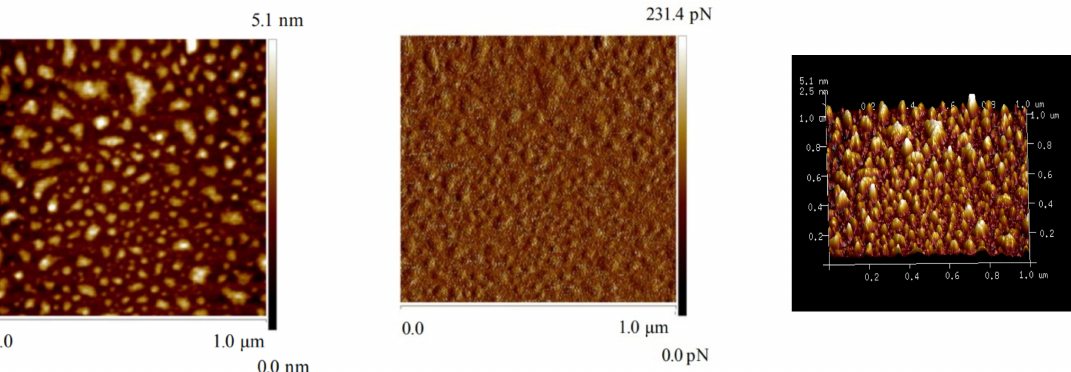
Figure 13. Height, Peak Force Error, and 3D image of talc treated with CLS (c(CLS) = 200 mg/L, pH = 8).